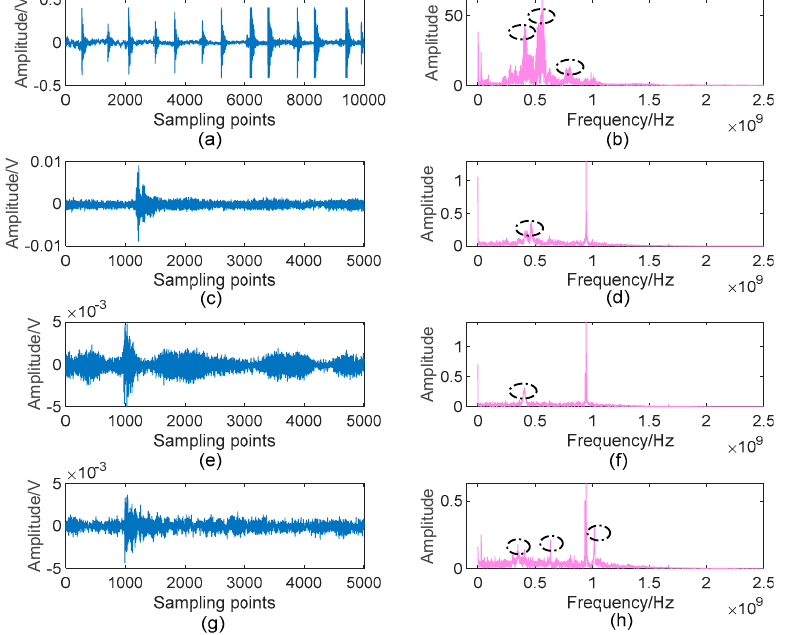
Figure 13. Measured UHF PD signals by laboratorial setup: ( a ) Typical waveform of Type 1; ( b ) Spectrum of ( a ); ( c ) Typical waveform of Type 2; ( d ) Spectrum of ( c ); ( e ) Typical waveform of Type 3; ( f ) Spectrum of ( e ); ( g ) Typical waveform of Type 4; ( h ) Spectrum of ( g ). Possible PD components in each spectrum are marked with black dash-dotted ellipse.